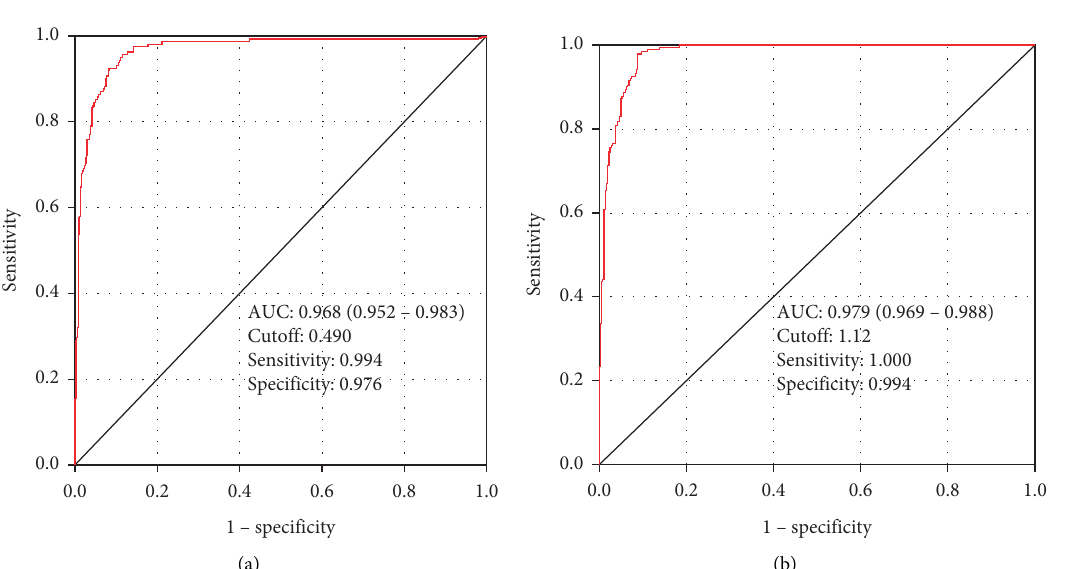
Figure 2: Receiver operating characteristics analysis of the TyG index for the identification of metabolically obese normal weight phenotype in (a) men and (b) women.